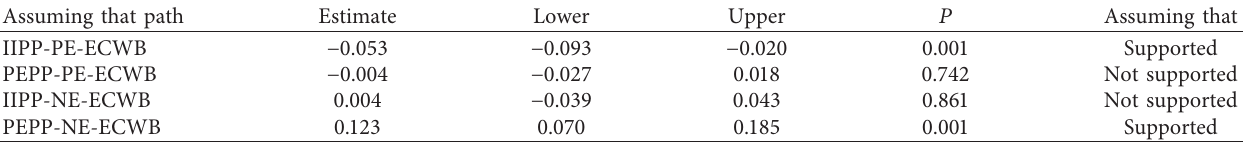
Table 7: Mediating effect test.